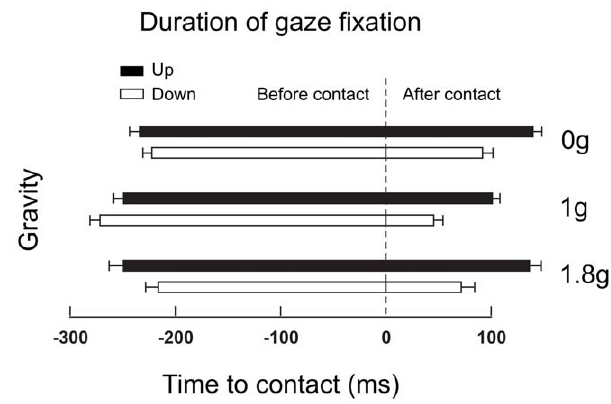
Figure 4. Durations of target fixations before and after target contact. Saccades landed on the target 241.1 6 84.1 ms before the collision but left later in upward compared to downward trials (black bars vs. open bars) and in unknown gravity fields (0 g and 1.8 g vs. 1 g). The vertical dashed line denotes time of contact. Error bars are between participants SD.